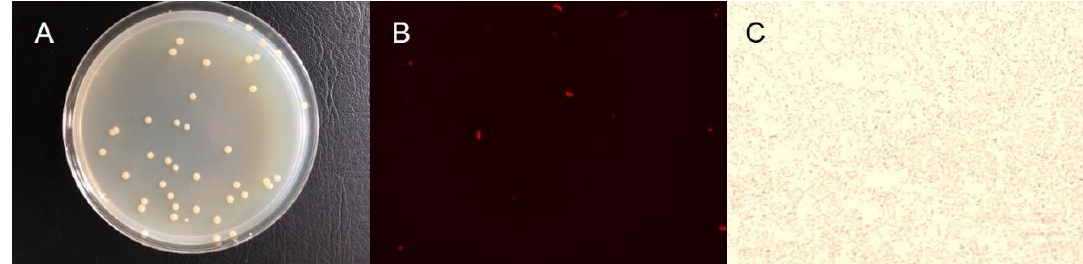
Figure 1. The colony of Halomonas sp. strain 3727 on LB solid medium ( A ); micrograph of cellular membrane staining using BBcellProbe ® membrane dye Dil ( B ); Gram staining micrograph ( C ).